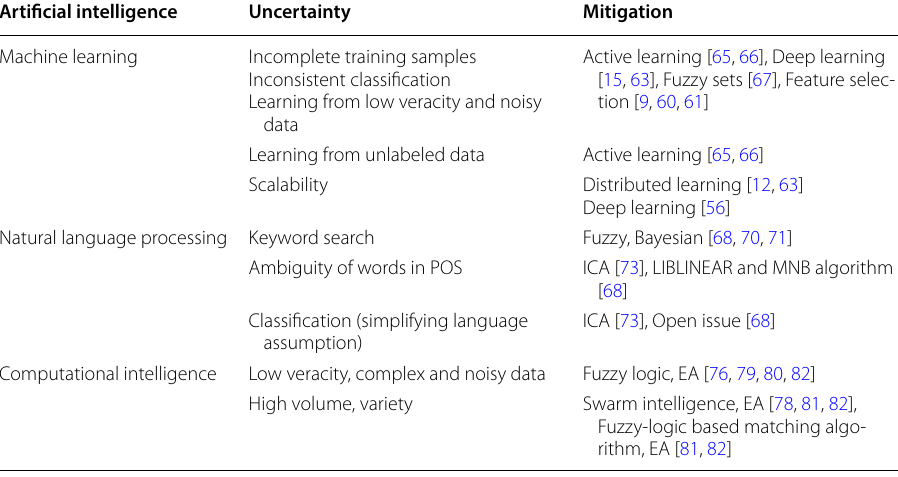
Table 2 Uncertainty mitigation strategies Artificial intelligence